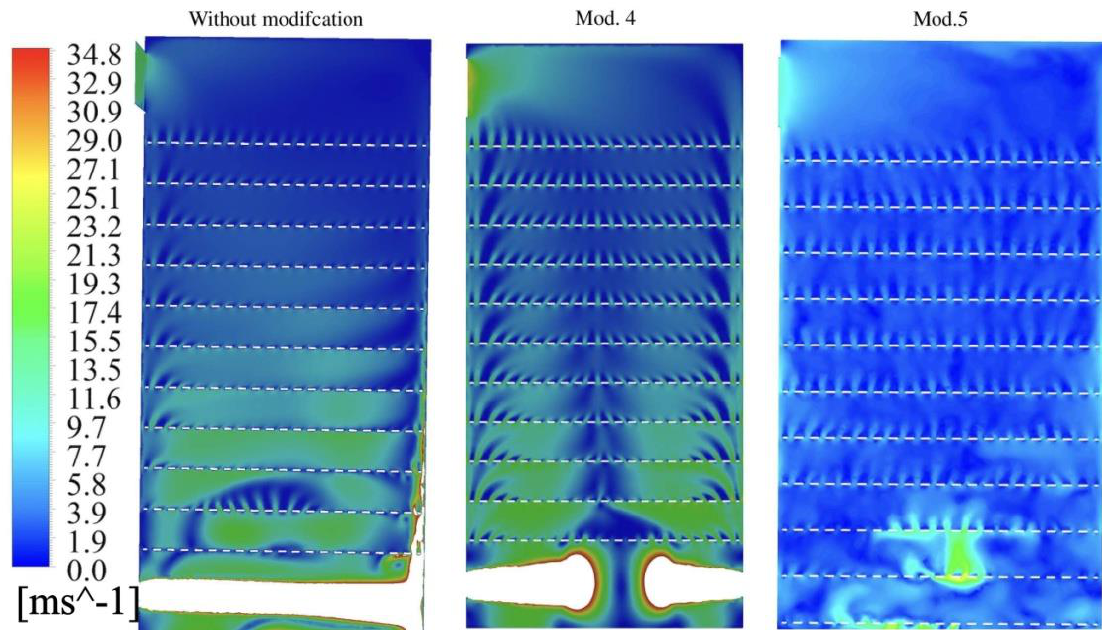
Figure 4. Visualization of the streamline-comparison of the chamber without modifications with the chamber with modification 4 and 5.